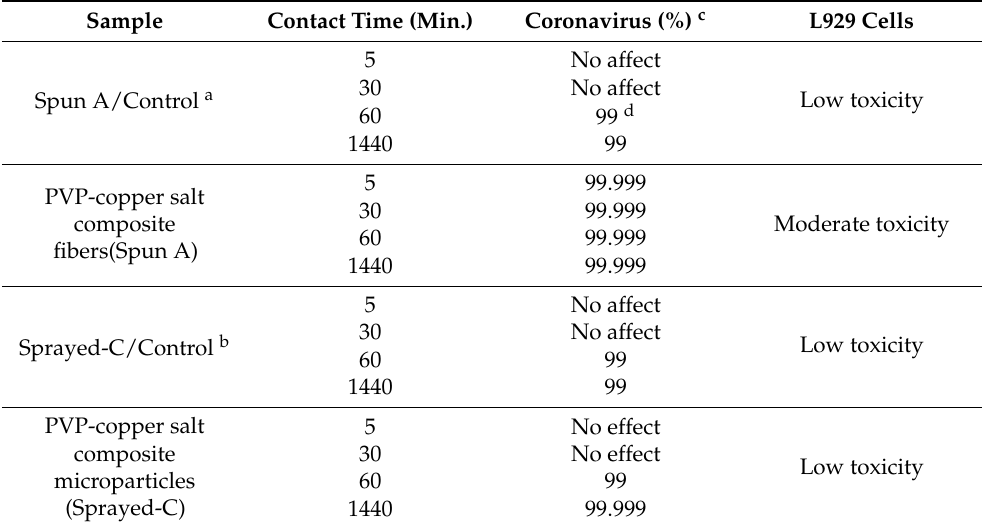
Table 2. Results of the coronavirus virucidal test and cytotoxicity assay of the virucidal PVP-copper salt composites and their respective control samples. Sample Contact Time